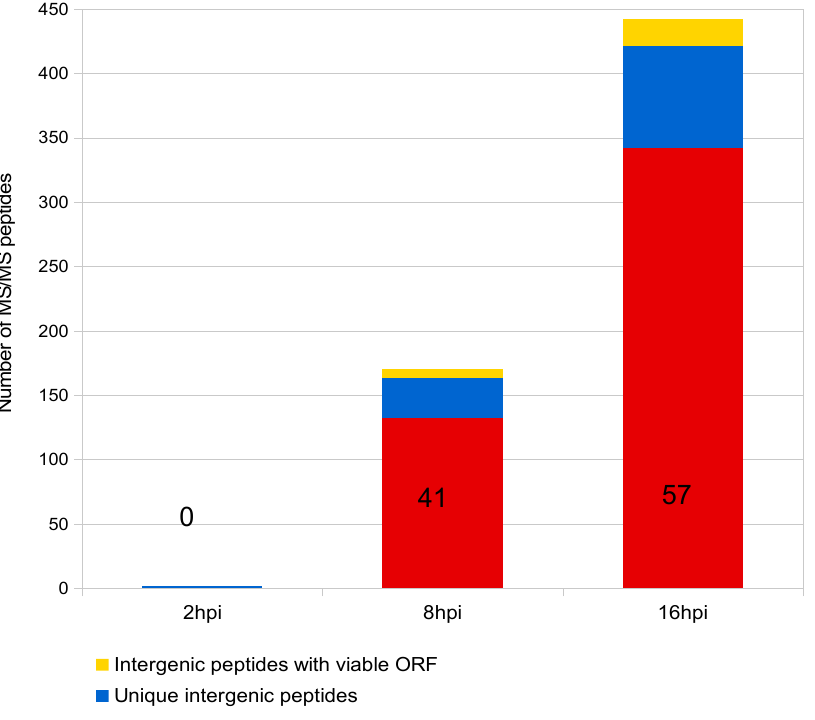
Figure 2. Quantification of unique BoHV-1 MS/MS spectra. Number of MS/MS spectra mapping to annotated viral ORFs (red) vs un-annotated genomic regions (blue). Yellow represents the number of spectra that mapped to un-annotated genomic regions that also contain nearby stop and start codons. The term unique refers to any peptide that maps to a single location of the genome. The bar graph is additive and not absolute. Numbers 0, 41, and 57 atop each bar represent the number of known viral proteins successfully identified.